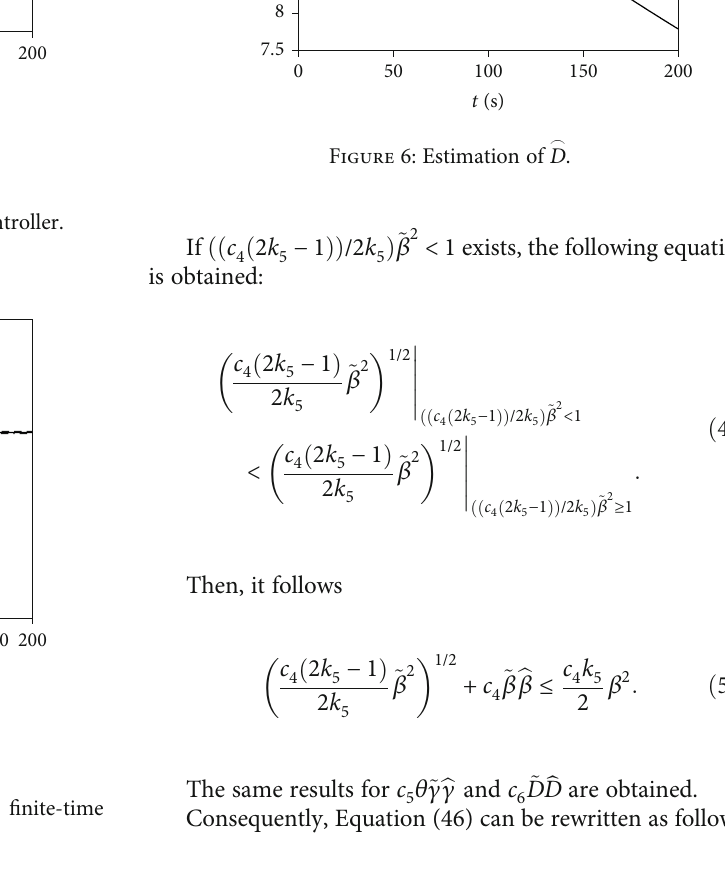
Figure 6: Estimation of D